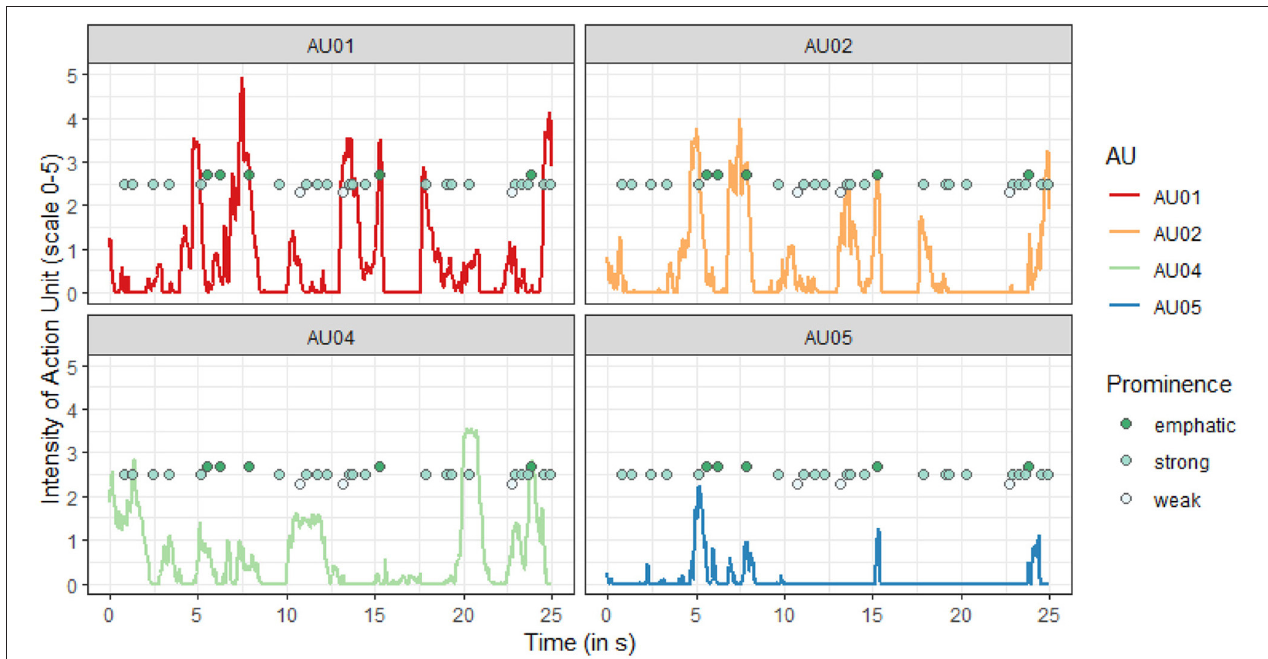
FIGURE 6 | Co-occurrence of Action Units and pitch accents with their prominence level (example). The intensity of each of the four Action Units (scale of 0–5) is shown for the first 25 s of speech material of speaker MF. The pitch accents and their prominence level are super-imposed, the y-axis does not refer to the prominence level directly, but emphatic accents are placed higher than accents with strong prominence, which in turn are placed higher than accents with weak prominence. The time of the pitch accents is that of the pitch peak, so either within the prominent syllable, or in the syllable before or